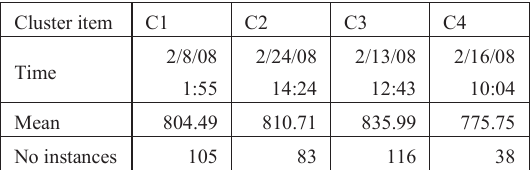
Table 2. Cluster means for Stage 3